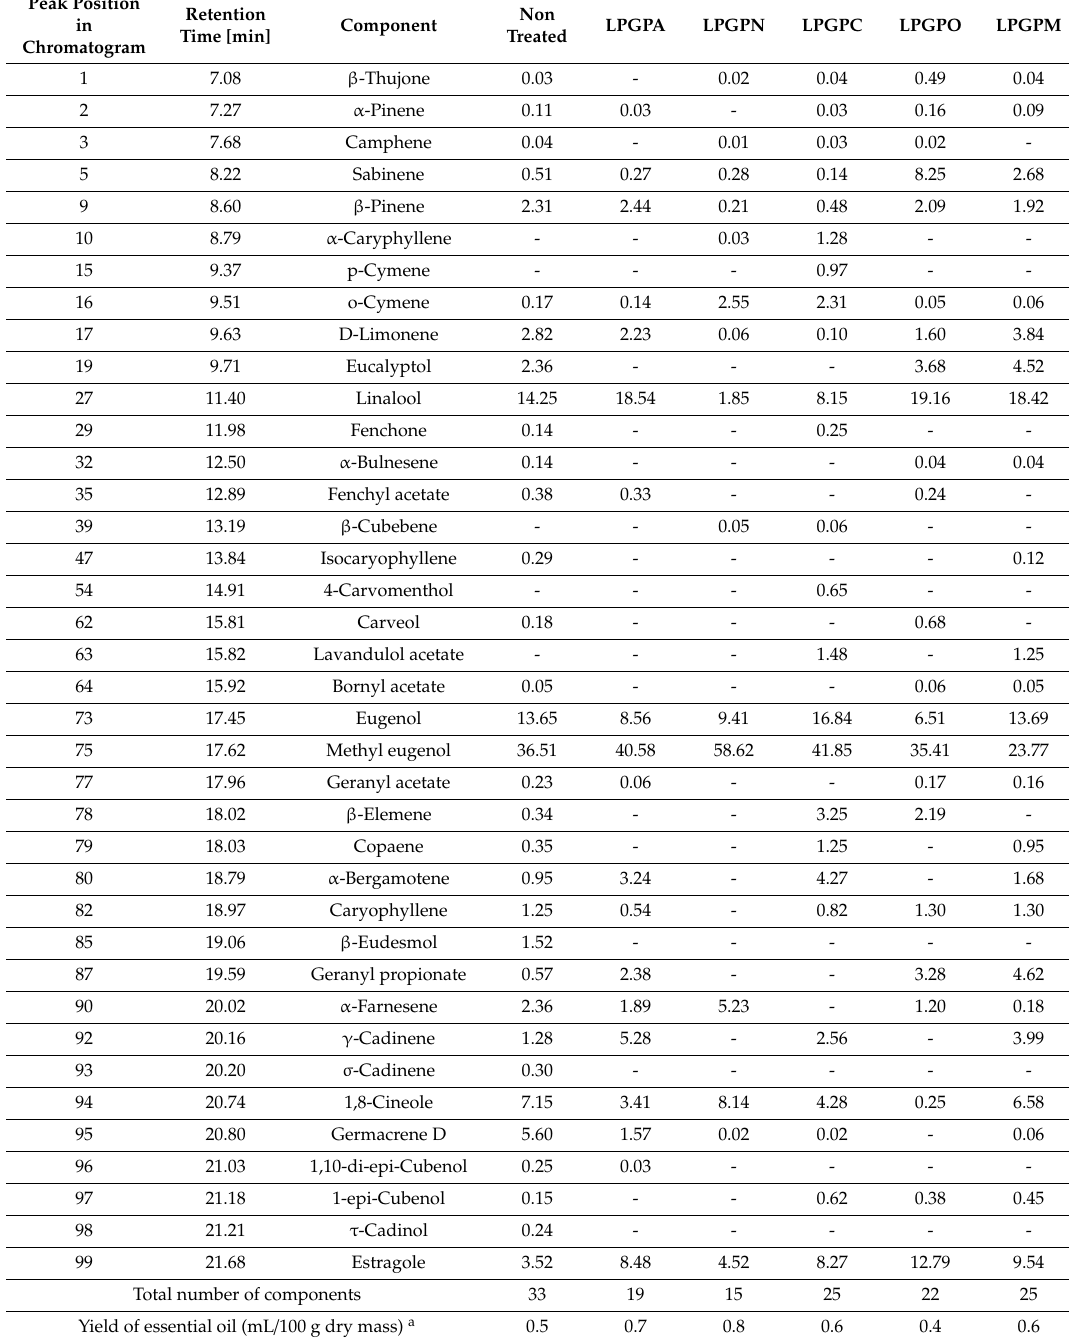
Table 2. Composition of essential oil [% of the total = 100%] collected from basil watered with non-treated water, and water LPGP treated for 30 min either under air (LPGPA), nitrogen (LPGPN), carbon dioxide (LPGPC), molecular oxygen (LPGPO) and methane (LPGPM). Peak Position